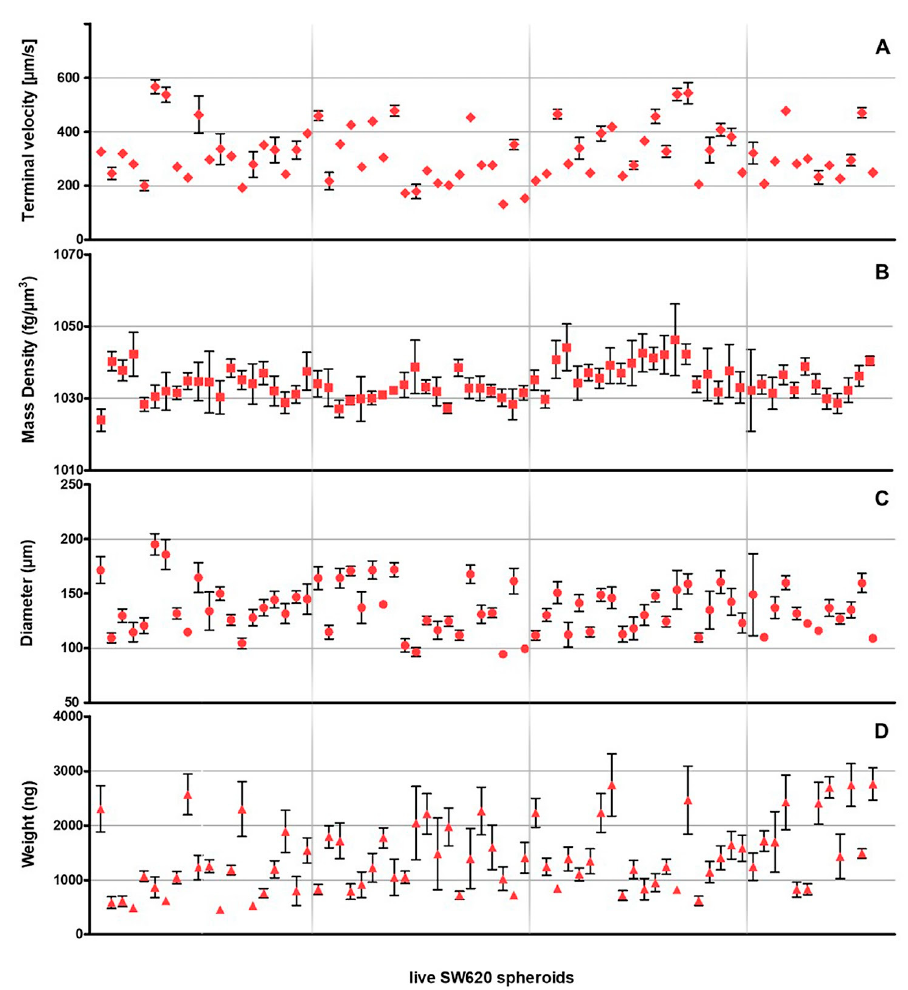
Figure 5. ( A ) Terminal velocity, ( B ) mass density ( C ) diameter and ( D ) weight values obtained for 72 live SW620 spheroids (rhombuses, squares, dots and triangles respectively). Each spheroid value, and the equivalent standard deviation, is extrapolated from at least five repetitions with an R 2 > 0.9999.